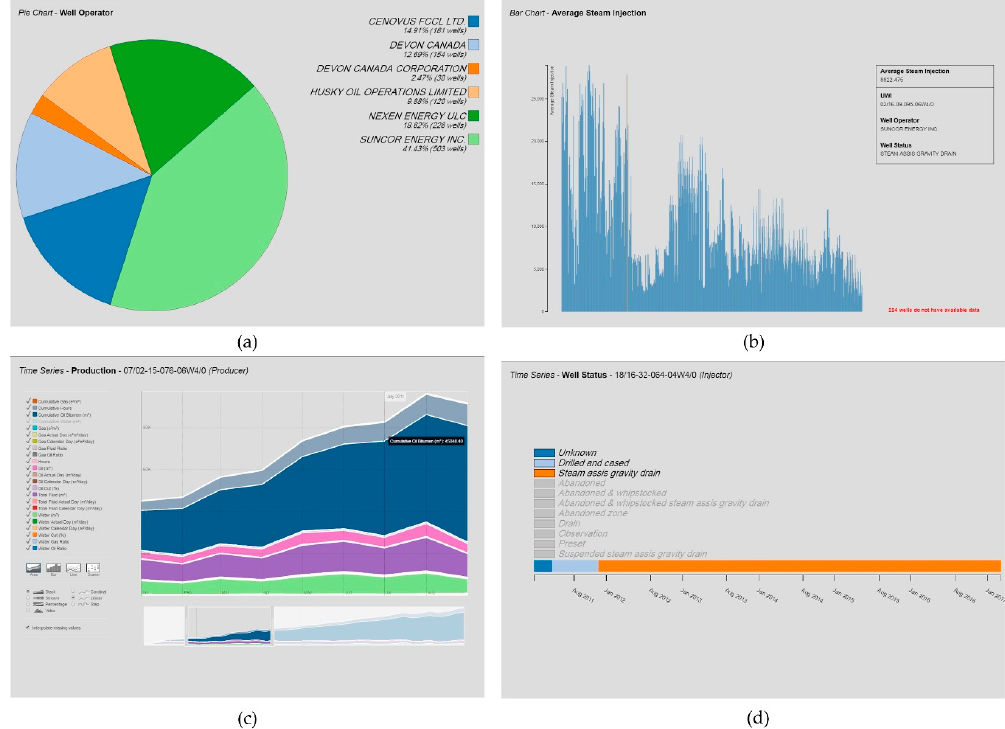
Figure 4. Classic visualizationg templates: ( a ) pie chart of operators for 1214 wells, nominal data; ( b ) bar chart of average steam injection volume for Cenoves Christina Lake, numeric data; ( c ) multi-line chart of production related data for a producer well, multiple numeric data; ( d ) well status for an injector well, nominal data. ISPRS Int. J. Geo-Inf. 2017 , 6 , 76